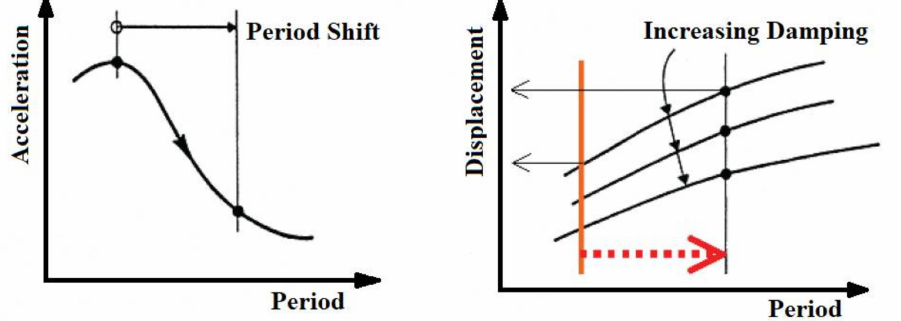
Figure 2. Seismic isolation concept: decrease in spectral acceleration ( left ) and increase in spectral displacement ( right )